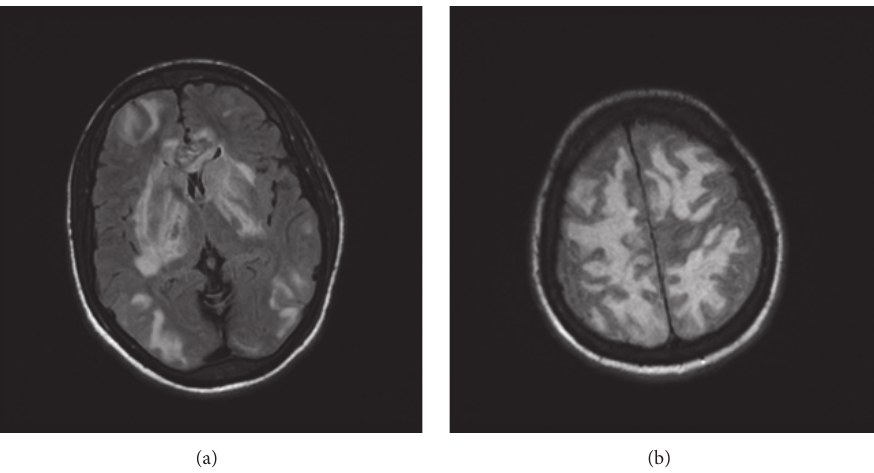
Figure 2: MRI Brain-Axial FLAIR-weighted images demonstrate the multifocal areas of edema involving the subcortical and deep white matter as well as the deep grey structures. Edema is also noted in the genu of the corpus collosum.